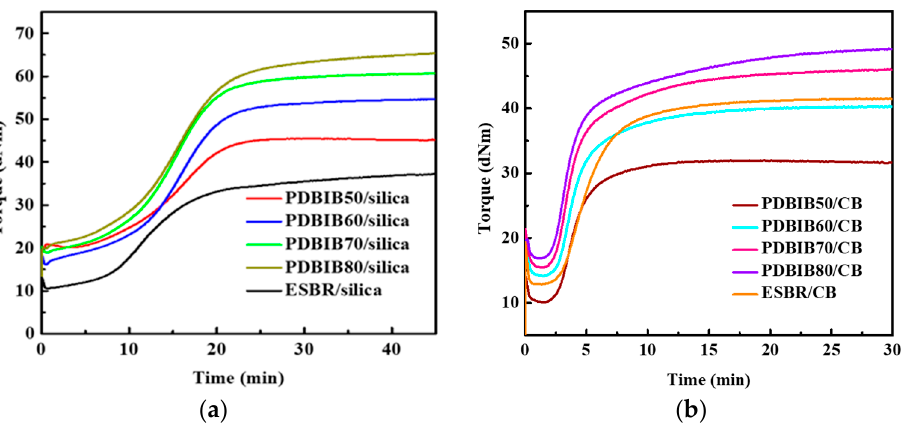
Figure 4. Torque of PDBIB and ESBR compounds as a function of curing time ( a ) PDBIB/silica and ESBR/silica; ( b ) PDBIB/CB and ESBR/CB.